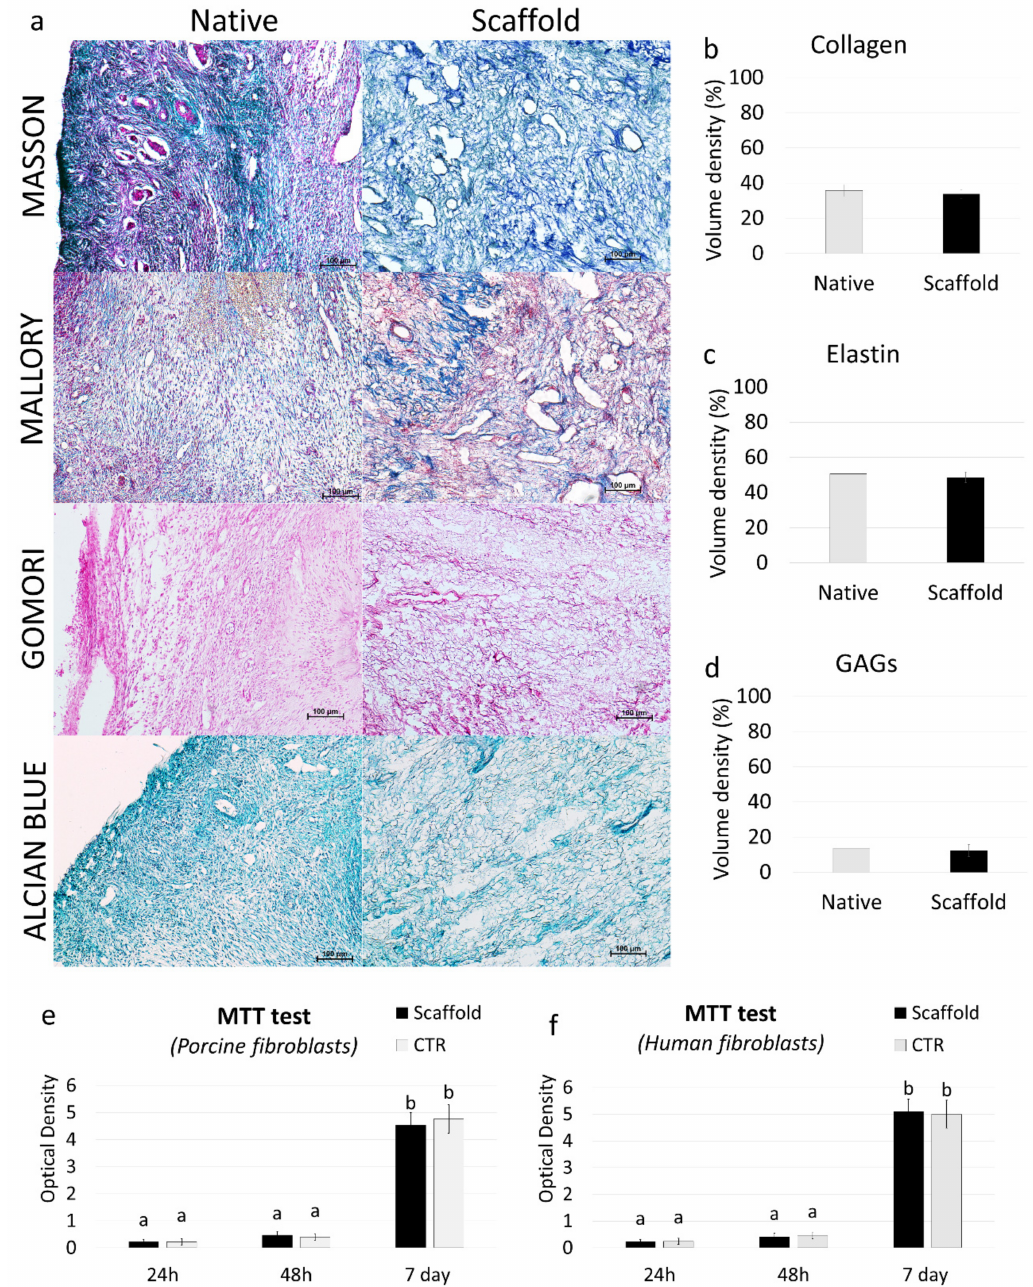
Figure 3. ECM microarchitecture and composition in ECM-based scaffolds and cytotoxicity assessment. ( a ) Masson’s Trichrome staining showed the persistence of collagen fibers (blue) and their comparable distribution between the native ovaries (native) and the decellularized tissues (scaffold). Mallory’s Trichrome staining demonstrated the maintenance of in- tact collagen (blue) and elastic fibers (red magenta) after the decellularization process (scaffold). Gomori’s aldehyde-fuchsin staining confirmed that ECM-based scaffolds (scaffold) retained the elastic fibers scattered throughout the decellularized ovary, similar to what was visible in untreated ovaries (native). Alcian blue staining revealed GAG retention in the decellularized scaffolds (scaffold). Scale bars = 100 µ m. ( b–d ) Stereological quantifications demonstrated no significant differences between untreated ovaries (native) and the decellularized ECM-based scaffolds (scaffold) in collagen ( b ), elastin ( c ), and GAG ( d ) contents. Data are expressed as the mean ± the standard error of the mean (SEM) ( p > 0.05). ( e–f ) MTT assays demonstrated no significant differences in the OD values of porcine ( e ) and human ( f ) adult dermal fibroblasts cocultured with ECM-based scaffold fragments and those identified in control cultures (CTR) at all the different time points analyzed. Data are expressed as the mean ± the standard error of the mean (SEM) ( p > 0.05). a and b indicate statistically significant differences ( p <